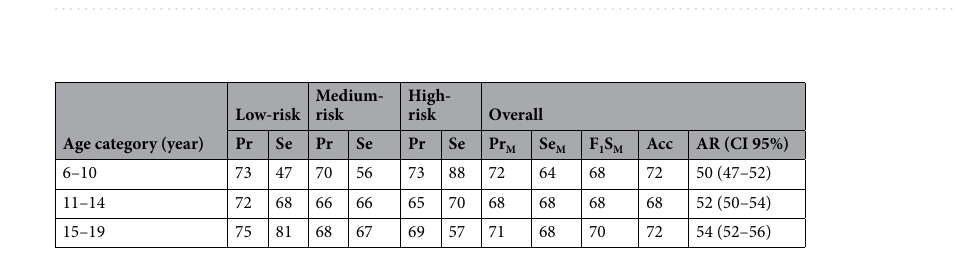
Table 5. The performance of the GMDH classifier in MEAN ± SD over the test folds using threefold cross- validation on the imputed dataset. Se Sensitivity, Sp Specificity, Pr Precision, Acc Accuracy.